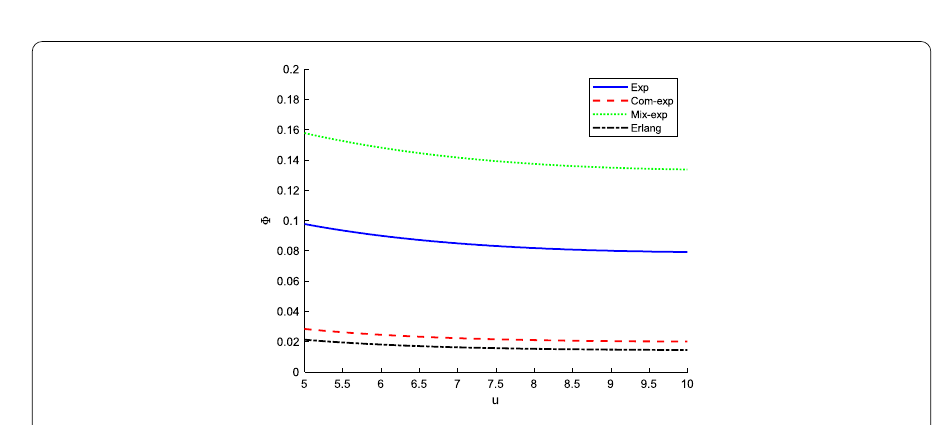
Figure 5 The Laplace transformation of the ruin time